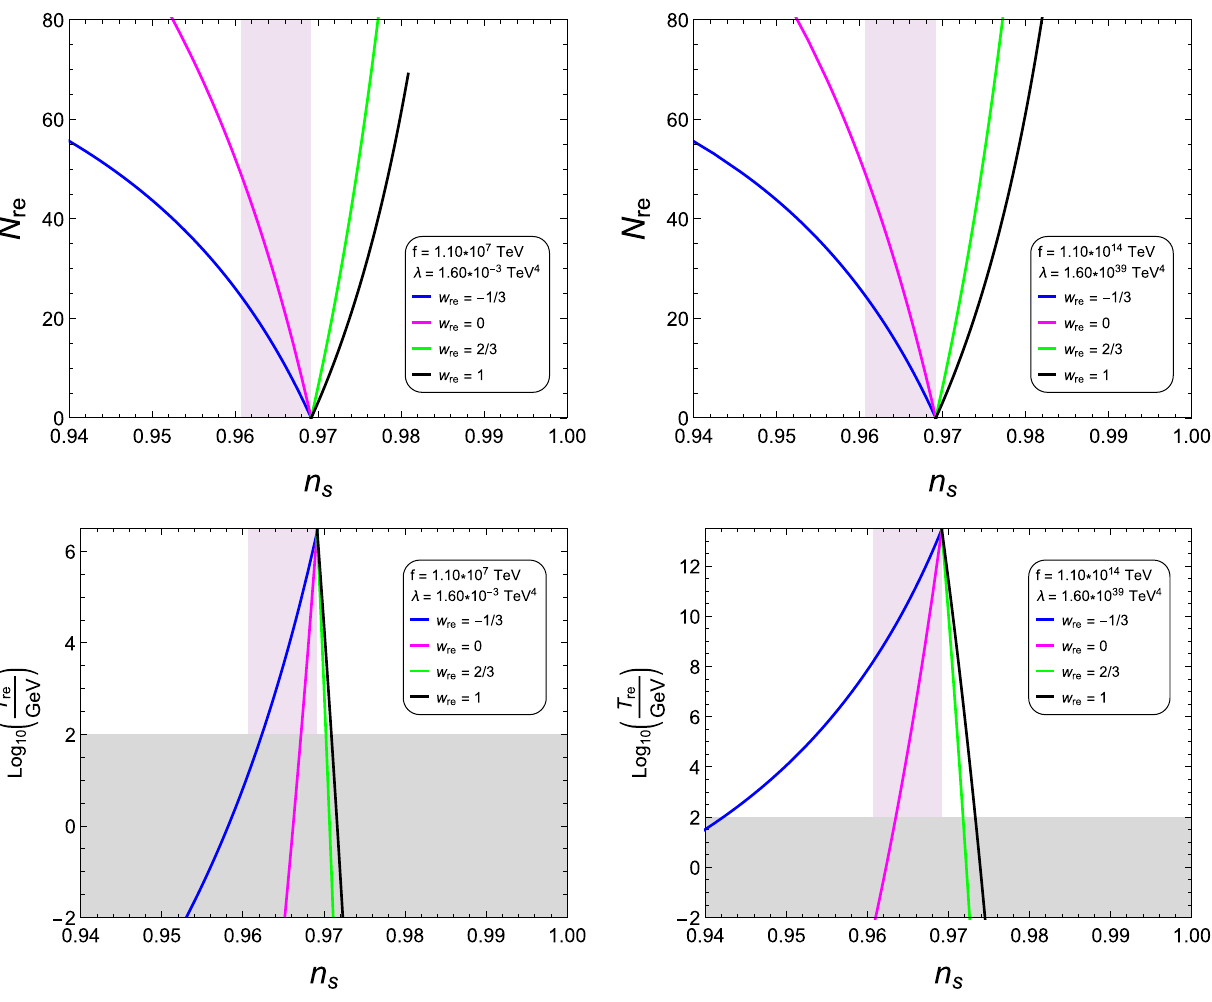
Fig. 13 Plots of N re and T re as functions of n s for Exponential SUSY inflation. The left panels shows the plot for M 5 = 10 5 TeV while the right panels shows the plot for M 5 = 10 12 TeV.The curves and the shading regions are the same as Fig. 3 and all plots corresponds to α = 0 . 0185